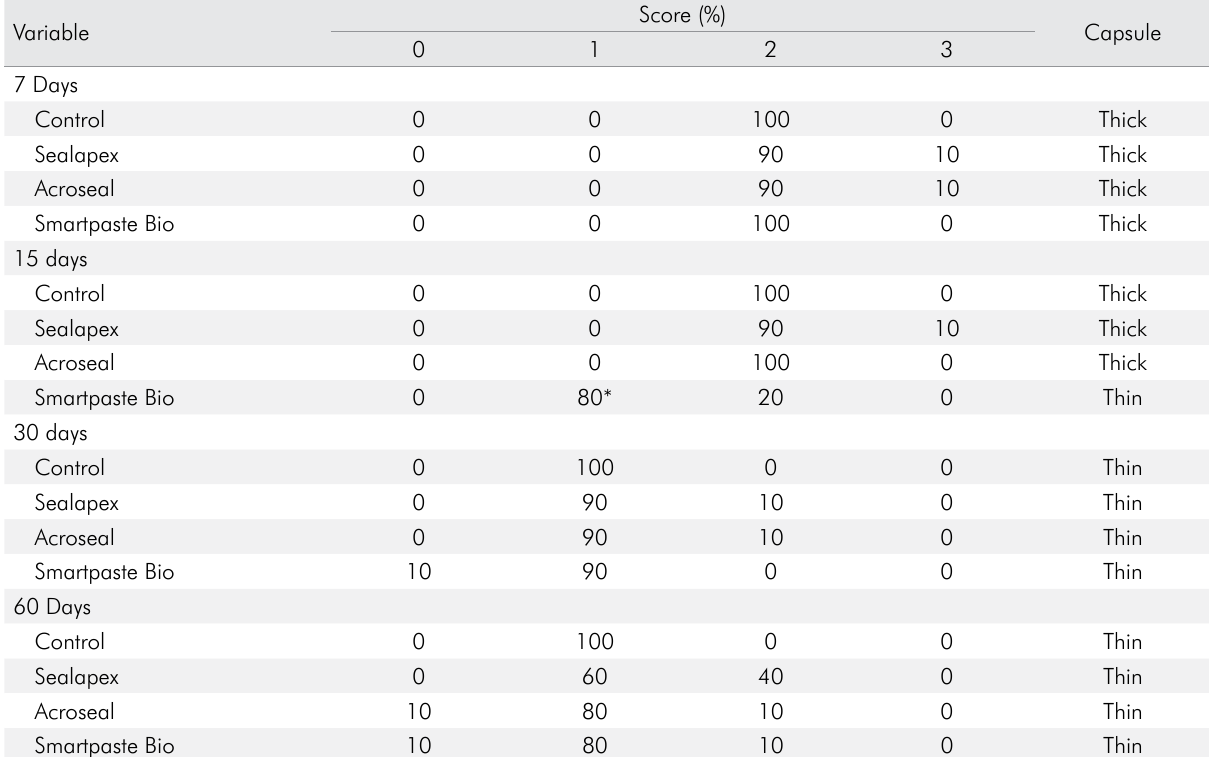
Table 1. Percentage of samples in each group categorized according to the inflammatory score and the rating thickness of fibrous capsule.